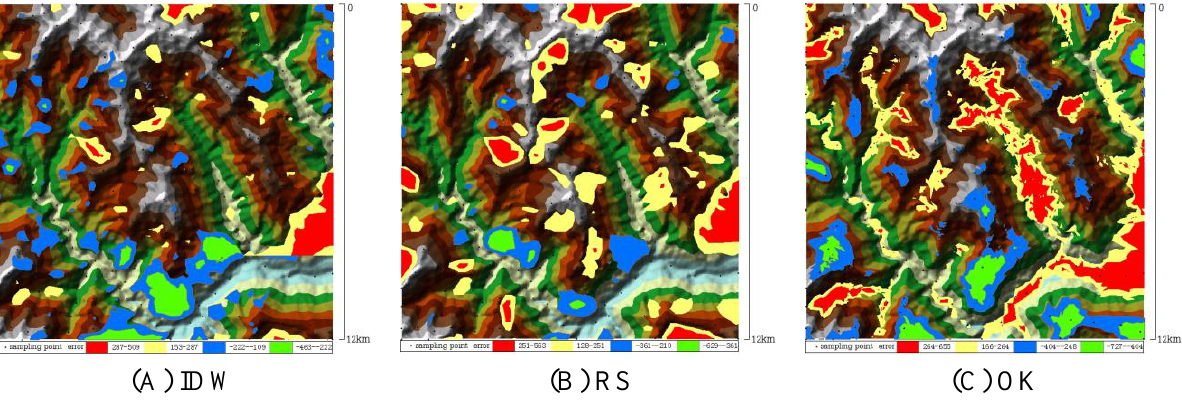
Figure 4. The distributions of errors in selective sampling. ( A ) Error distributions of IDW; ( B ) Error distributions of IDW; ( C ) Error distributions of